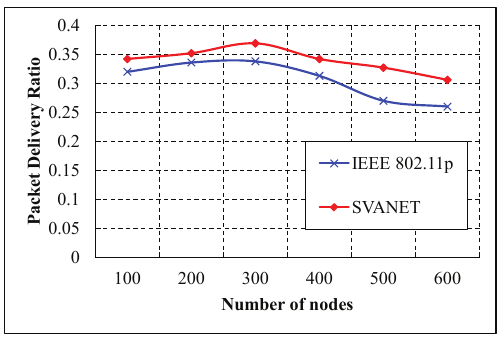
Figure 21. Average packet delivery ratios in the highway with eight lanes.